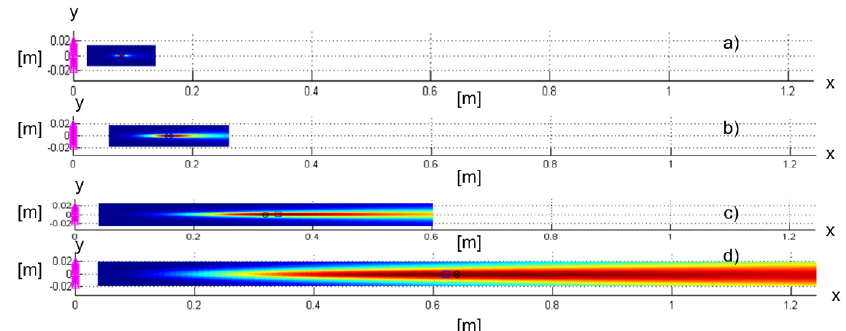
Figure 20. SCM-MUSIC criterion functions for localization of a transmitter at a distance of ( a ) 1, ( b ) 2, ( c ) 4, and ( d ) 8 apertures from the collocated massive antenna